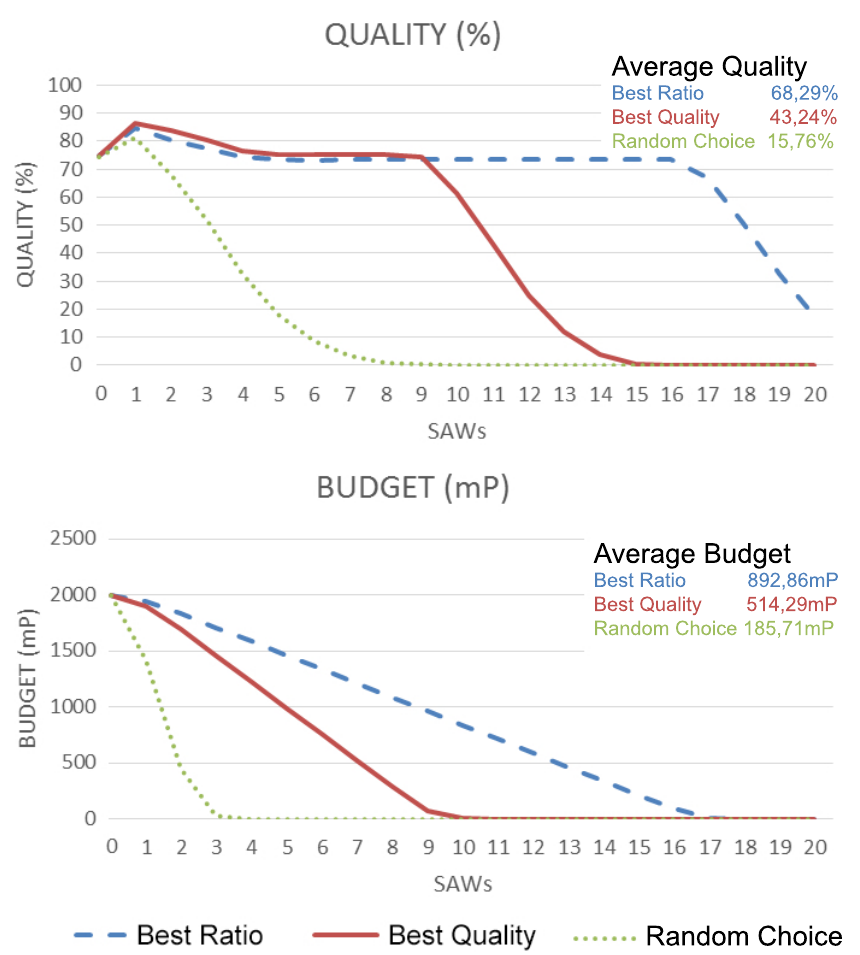
Figure 3. DPB results under high budget